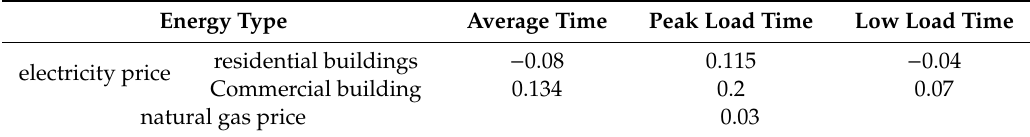
Table 5. Information of energy prices ($ /